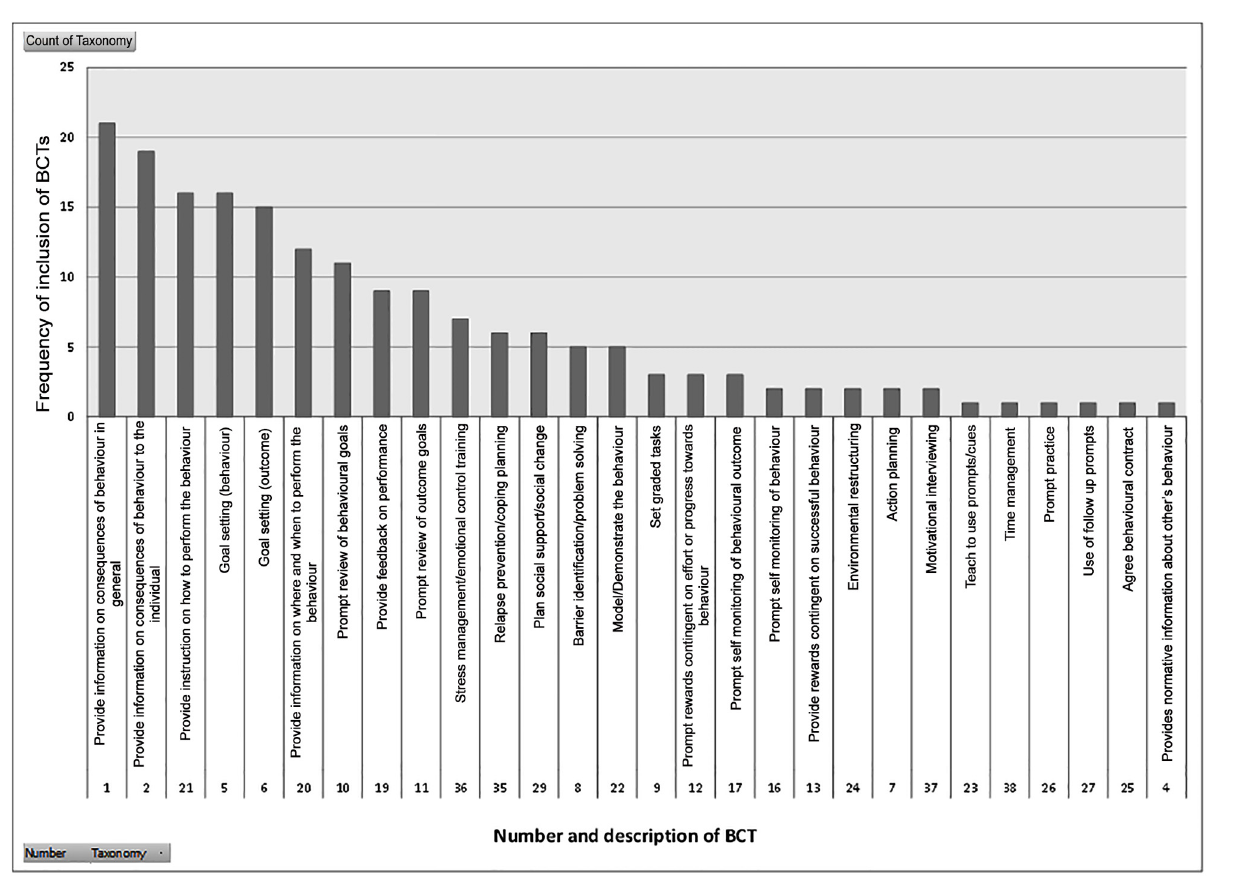
Fig 2. Frequency of inclusion of behaviour change